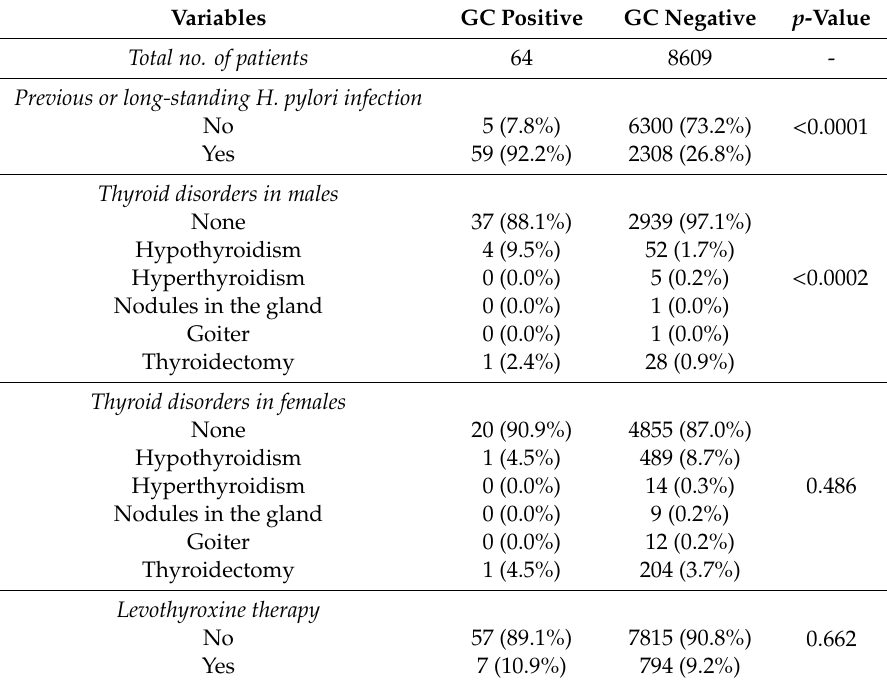
Table 2. Characteristics of the study participants according to the presence of gastric cancer